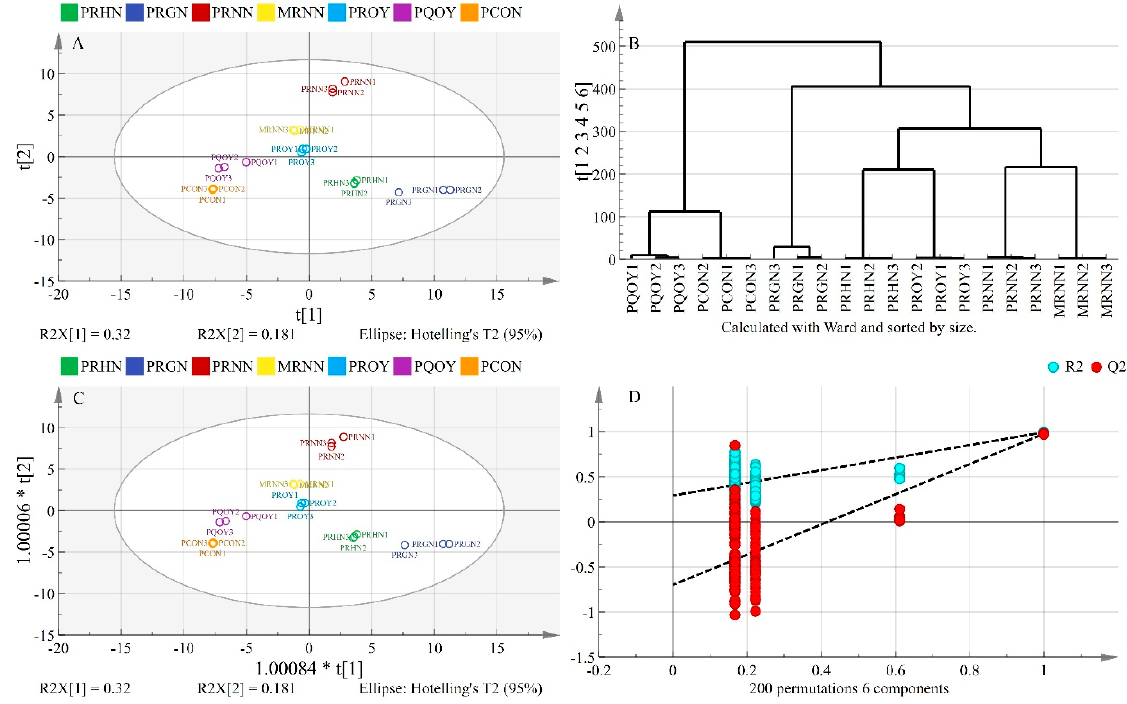
Figure 2. Score plot of the PCA-X model ( A ), HCA ( B ), OPLS-DA model ( C ), and cross-validation of the OPLS-DA model ( D ) for VOCs among Citrus sinensis ‘hongjiang’.